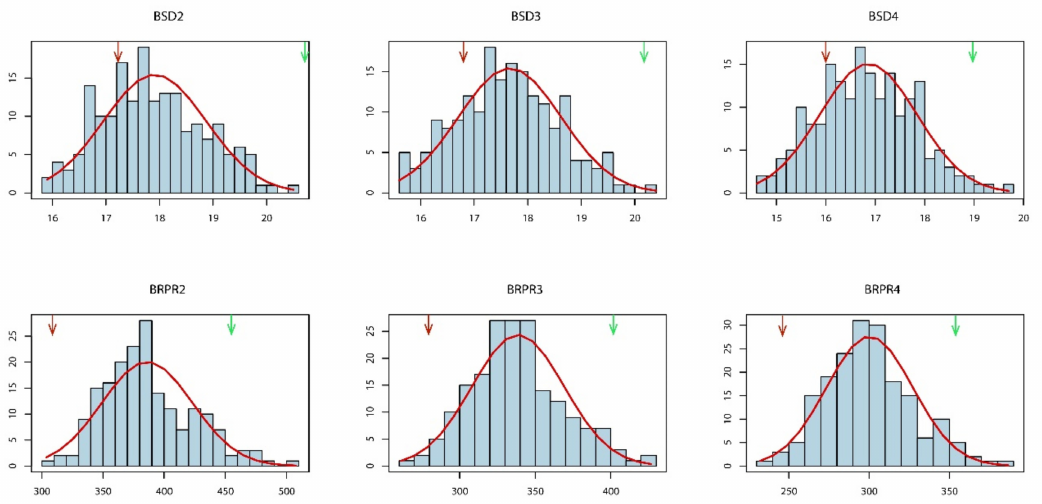
Figure 1. Frequency distributions of BLUP data for SD and RPR in the RIL population. Red and green arrows represent the mean value of the parents YS501 and LDC-1, respectively.